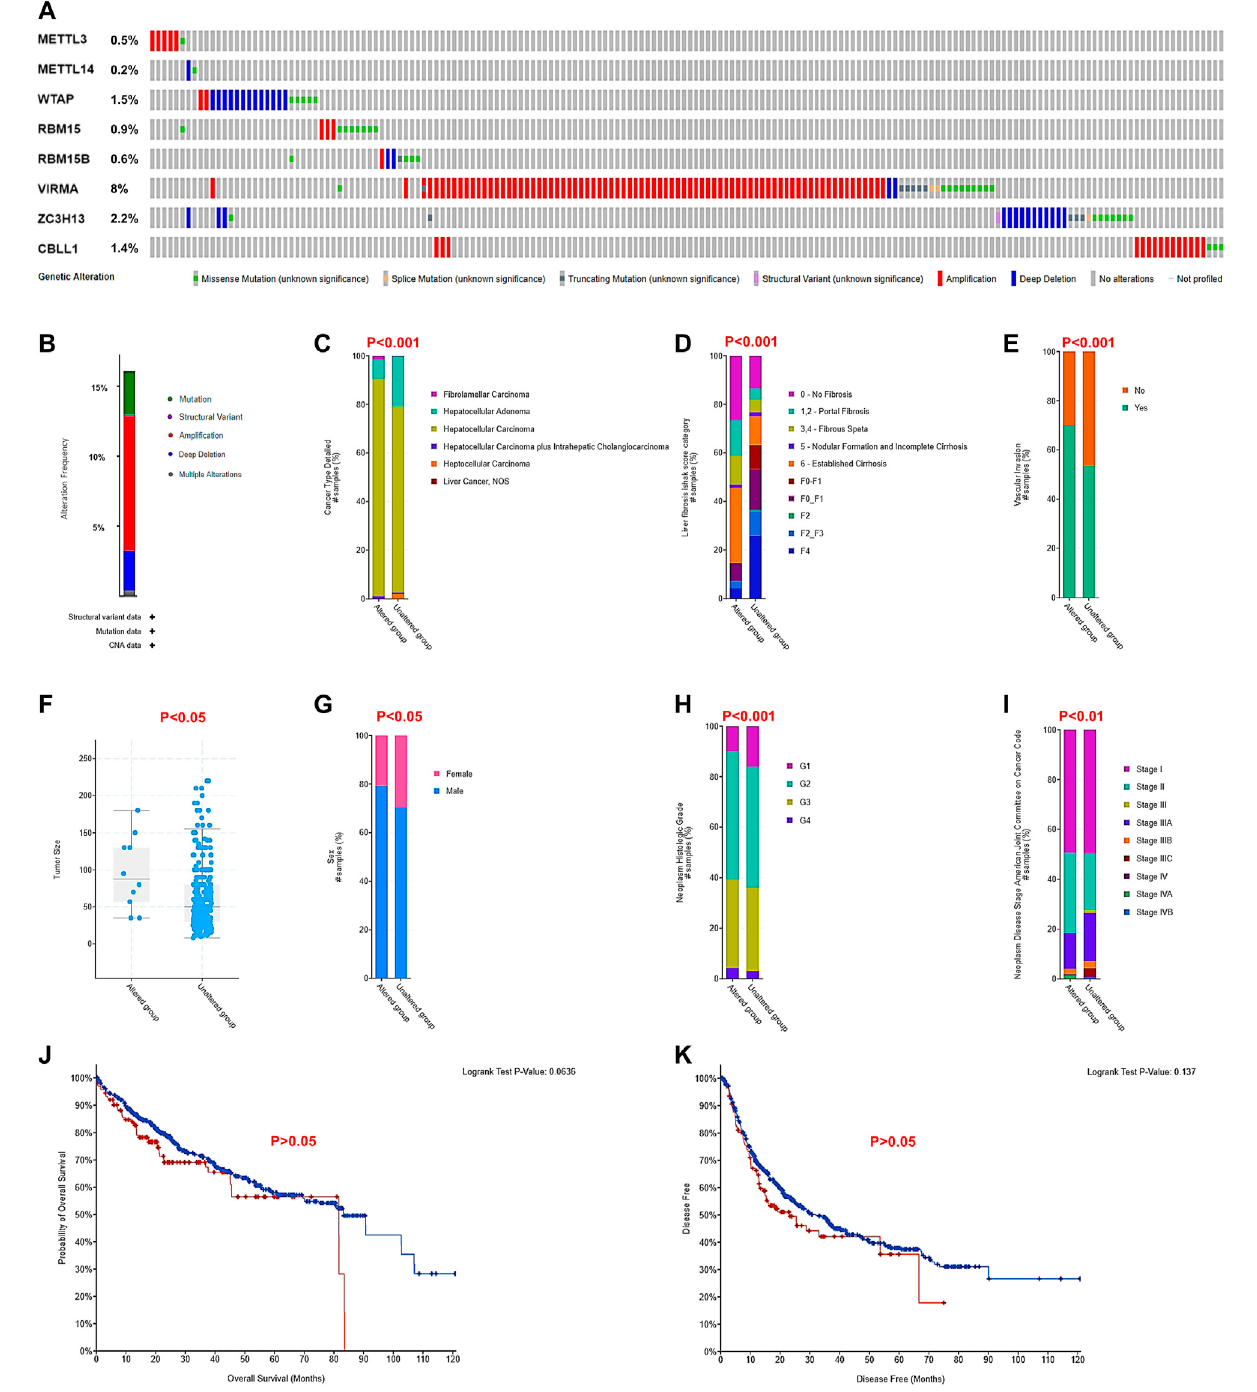
FIGURE 6 | Genetic alterations related to the m 6 A writer complex and their correlation with clinicopathological factors in HCC (cBioPortal). (A) Ampli fi cation, deletion,andmutationofthem 6 AwritercomplexinHCC. (B) Geneticalterationsummaryofthem 6 AwritercomplexinHCC.Thecorrelationbetweengeneticalterationof the m 6 Awriter complex and tumor type (C) , Ishak fi brosis score (D) , vascular invasion (E) , tumor volume (F) , sex (G) , tumor grade (H) , and tumor stage (I) . Chi-squared test, p < 0.05 was regarded as statistically signi fi cant. The relationship between genetic alteration of the m 6 A writer complex and OS (J) and DFS (K) of HCC patients. Log-rank p < 0.05 was regarded as statistically signi fi cant.